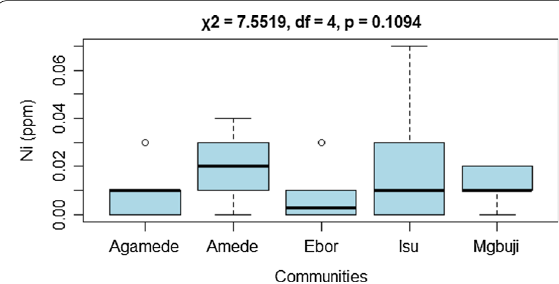
Fig. 1 Comparison of bioaccumulation of Pb in Achatina spp amongst sampled communities